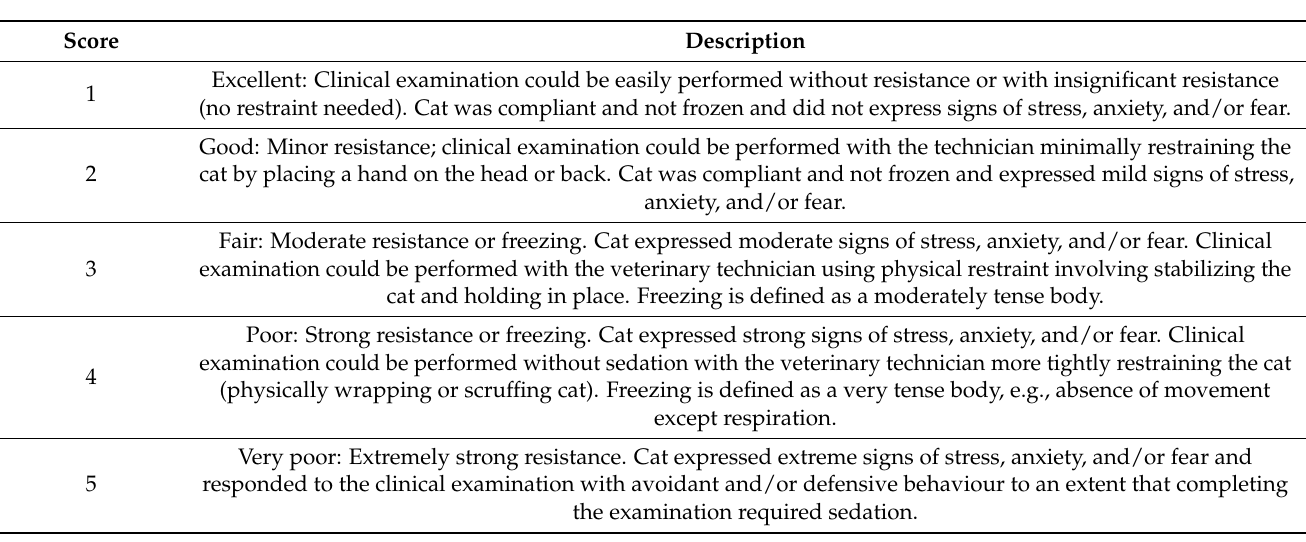
Table 2. Numerical rating scale for the investigator’s assessment of the treatment effect based on the cat’s stress, anxiety, and/or fear during the clinical examination at the clinic. Modified from